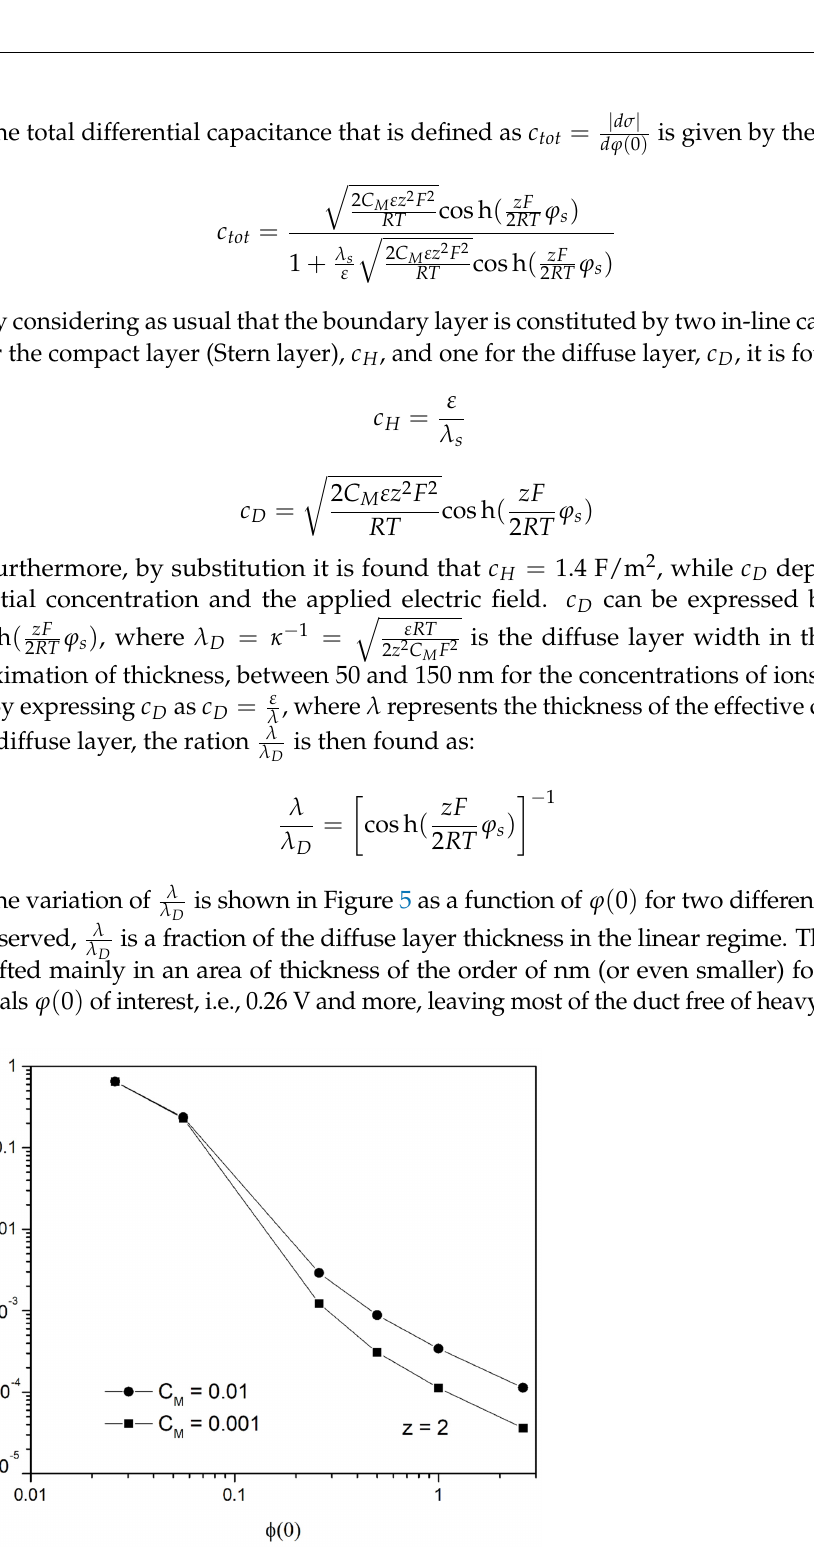
and 𝐶 (cid:3014) = (cid:2923) (cid:3119)